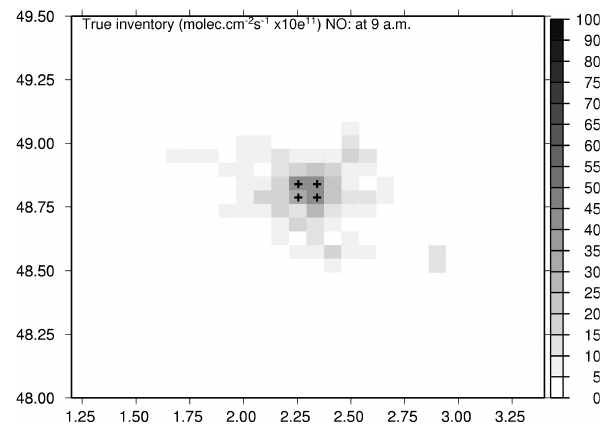
Fig. 4. True emission inventory: NO fluxes at 9 a.m. on the 7th of August 1998. x = perturbed fluxes in the first-guess inventory.